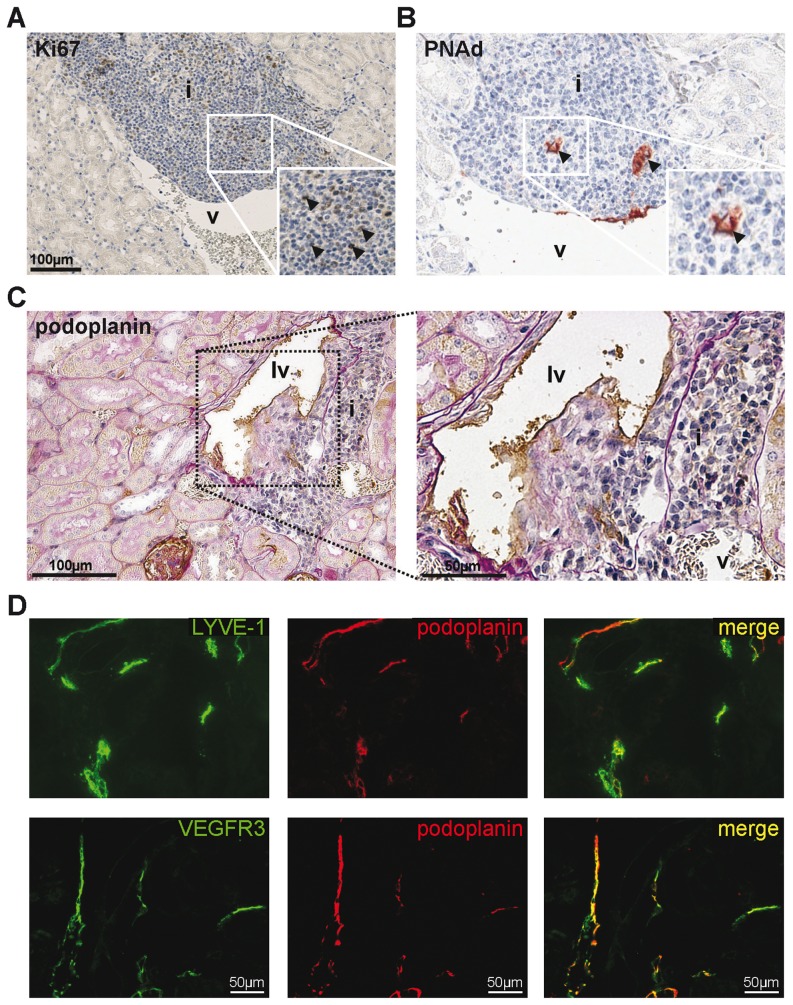
Perivascular immune cell clusters in aged mice have characteristics of tertiary lymphoid organs (TLOs).Representative photomicrographs of a perivascular cell cluster from C57L/J mouse serial sections containing (A) Ki67+ proliferating cells (magnification 200x) and (B) peripheral node addressin (PNAd) expressing high endothelial venules (HEVs) (magnification 400×). Insets show higher-power magnifications of the indicated areas. Arrowheads indicate proliferating lymphocytes (A) and PNAd+ HEVs (B). (C) Podoplanin expression on lymphatic endothelial cells in a lymph vessel in the close proximity of a perivascular cell cluster (left panel: magnification 200x, right panel: 400x). (D) Immunofluorescent double labeling for LYVE-1/podoplanin (upper row) and VEGFR3/podoplanin (bottom row) on C57Bl/6 mouse kidney sections. Abbreviations: i: infiltrate; lv: lymph vessel; v: vein.